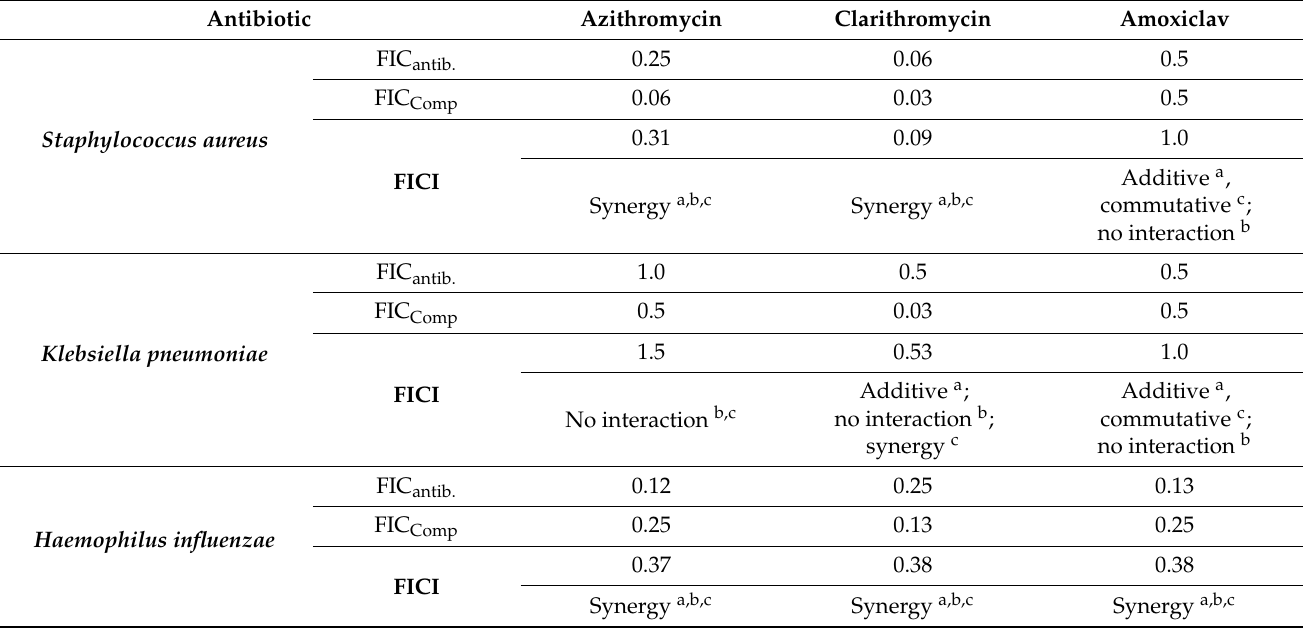
Table 6. Fractional inhibitory concentrations (FIC), FIC indexes, and interpretations of them. FIC antib. —fractional inhibitory concentration of antibiotic; FIC Comp. —fractional inhibitory concentra- tion of the GoImmune Strong ®